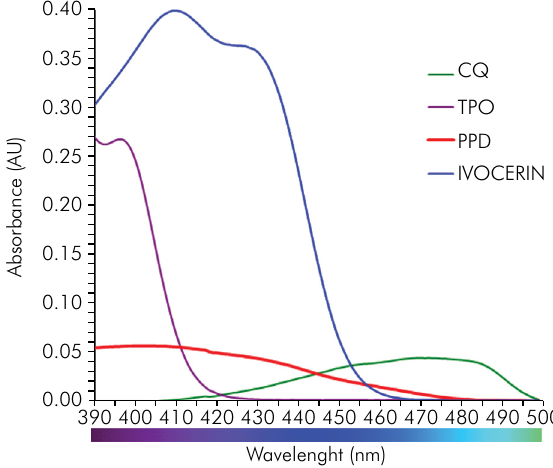
Figure 12. Differences in spectral absorption profiles and absolute absorption values among the dental photoinitiators, when present at similar molar concentrations.